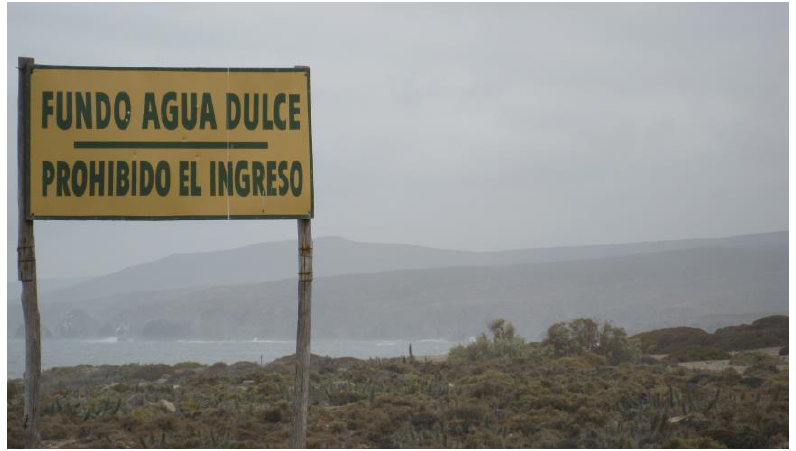
Figure 6. Fundo Agua Dulce (picture taken by Gloria. L. Gallardo Fernández).